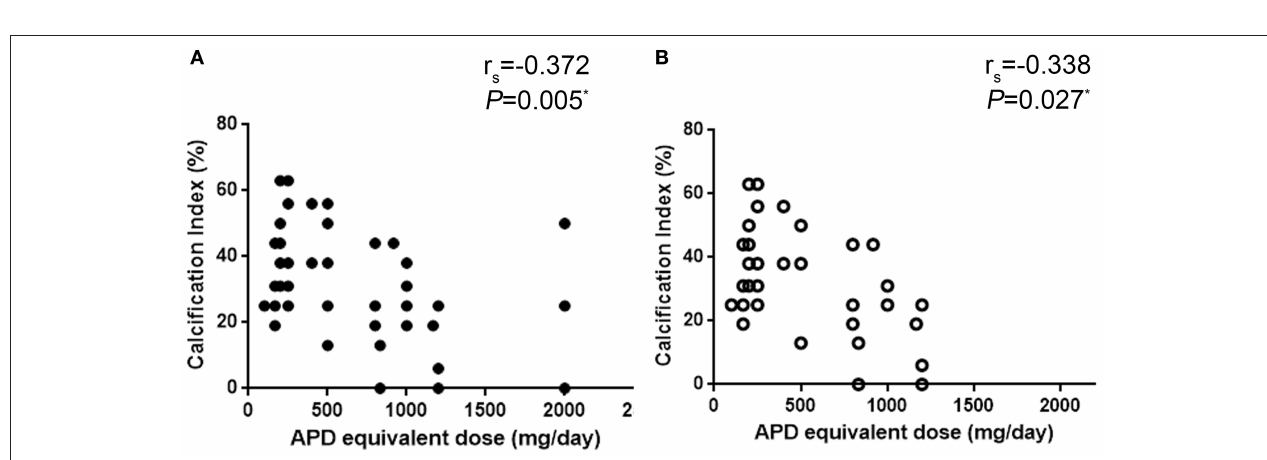
FIGURE 2 | Comparison of aortic calcification index and APD treatment in patients with different kinds of APDs. (A) APD equivalent dose, (B) duration of APD treatment, (C) Aortic calcification index. * p < 0.05. APD, antipsychotic drugs.